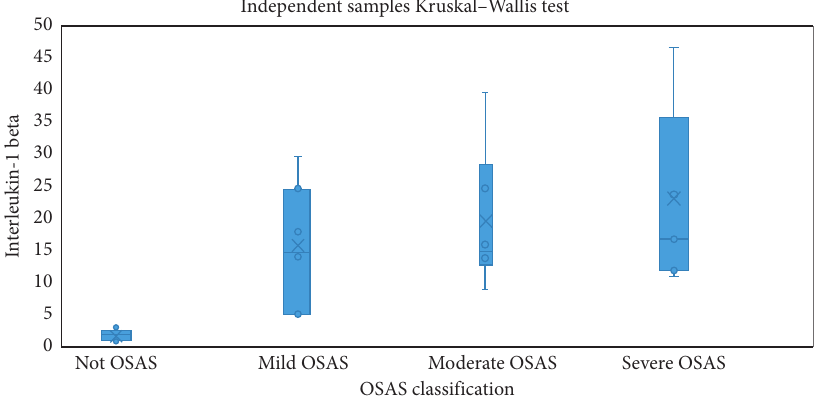
Figure 3: Distribution of the Interleukin-1 beta values according to OSAS classes.